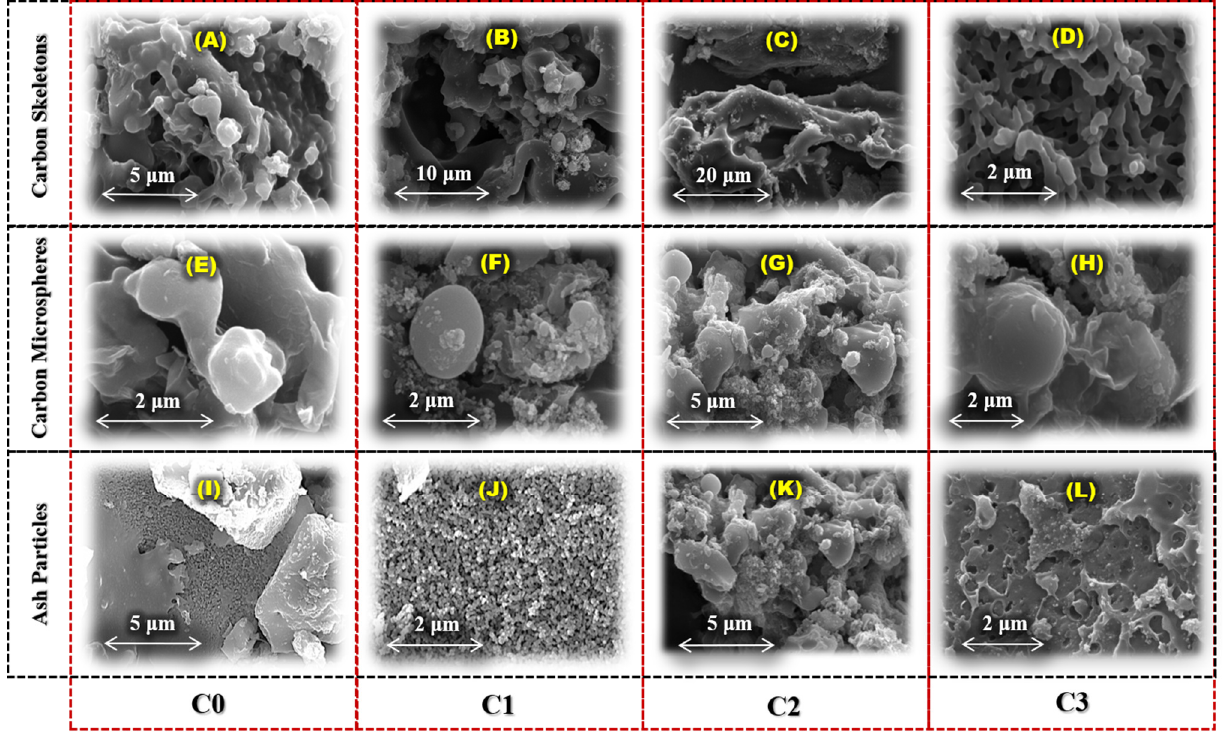
Figure 2. Microscopic morphological characteristics of NDS.